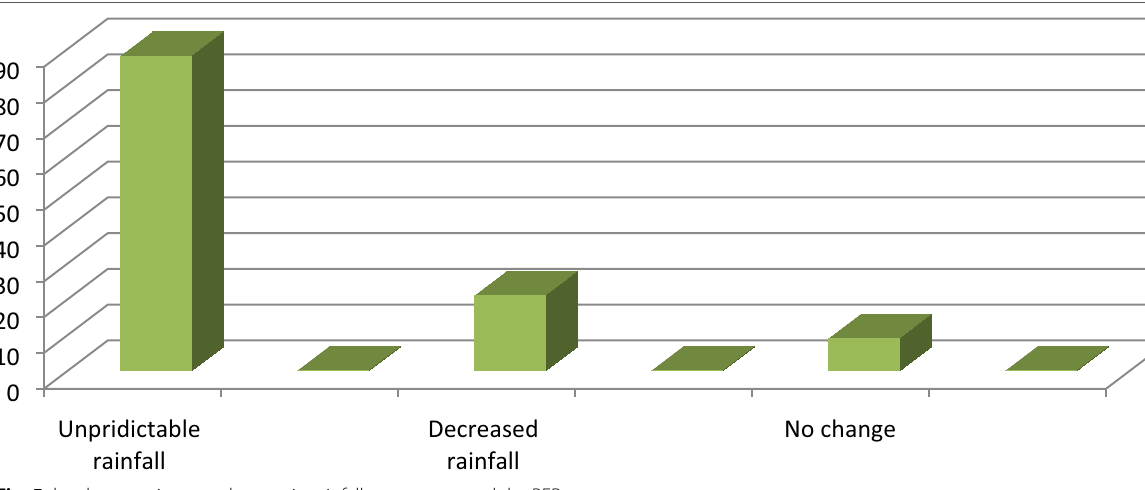
Fig. 5 local perceptions on changes in rainfall patterns around the BFR